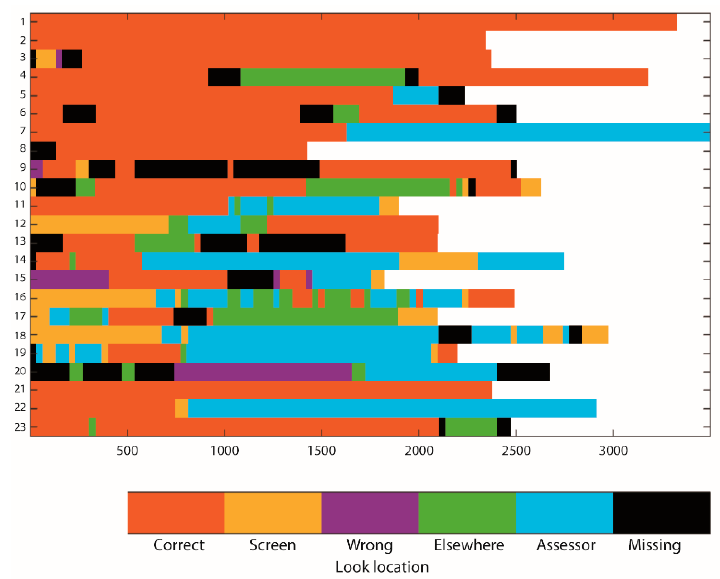
Figure 2. Raw looking behavior data (after interpolation of missing times < 150 ms) for the pre-switch